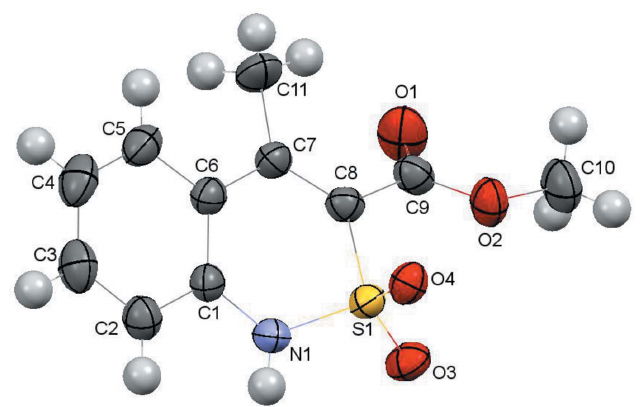
Figure 1 The molecular structure of I with the atom labelling. Displacement ellipsoids are drawn at the 50% probability